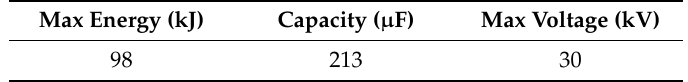
Table 2. Technological parameters of the 98 KJ electromagnetic forming